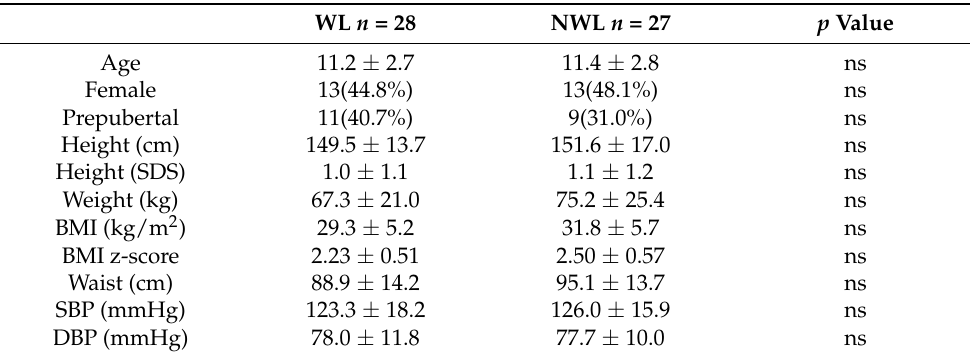
Table 1. Baseline characteristics of the weight losers (WL) and non-weight losers (NWL) subjects with obesity. Values are number (%) or means ± SD.